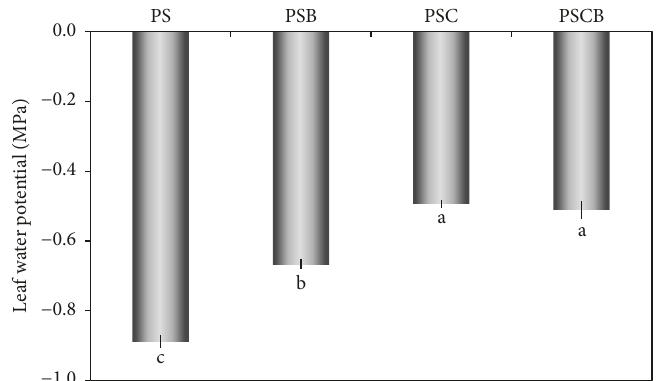
Figure 4: Leaf water potential at midday of plants grown in different substrates . Values are means ( 𝑛 = 5 ) ± standard error; significant differences between the means (at least 𝑝 ≤ 0.05 , according to ANOVA) appear with different letters. PS = lettuce plants grown in unfertilized soil; PSB = lettuce plants grown in unfertilized soil plus biochar; PSC = lettuce plants grown in unfertilized soil plus compost; and PSCB = lettuce plants grown in unfertilized soil plus compost and biochar.